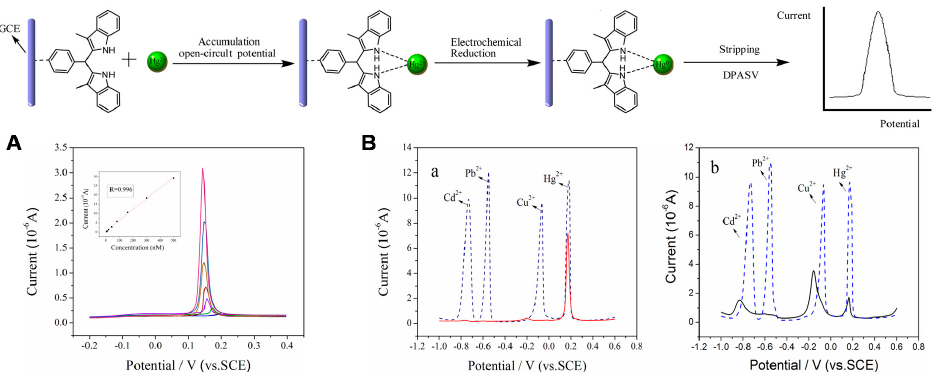
Figure 9. Preconcentration electroanalysis of mercuric ions at a glassy carbon electrode (GCE) modified with bis(indolyl)methane (BIM) on ordered mesoporous carbon nanofibers (OMC) and Nafion (GCE/BIM/OMC/Nafion); accumulation at open-circuit, electrochemical reduction and detection by differential pulse anodic stripping voltammetry (DPASV). ( A ) DPASV curves obtained at GCE/BIM/OMC/Nafion with open-circuit accumulation in 0.1 M phosphate buffer solution (pH 6) containing 5.0–500 nM Hg 2+ ; Inset showed the corresponding calibration plot; amplitude of 0.05 V; pulse width of 0.05 s; pulse period of 0.2 s; quiet time of 2 s. ( B ) DPASV curves obtained at (a)